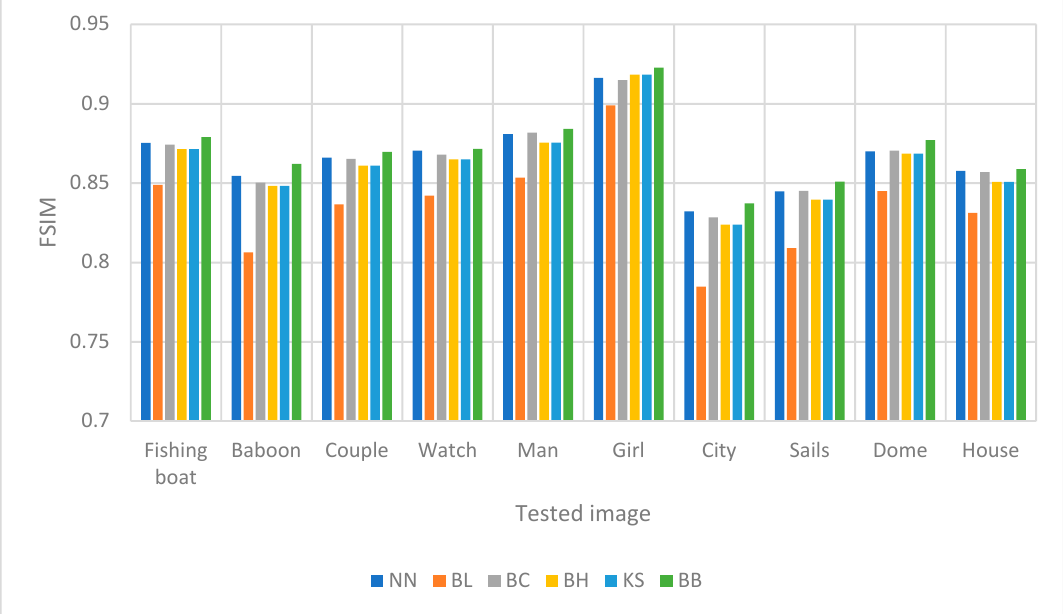
Figure 11. A comparison of schemes toward FSIM for image upscaling with a factor of four.